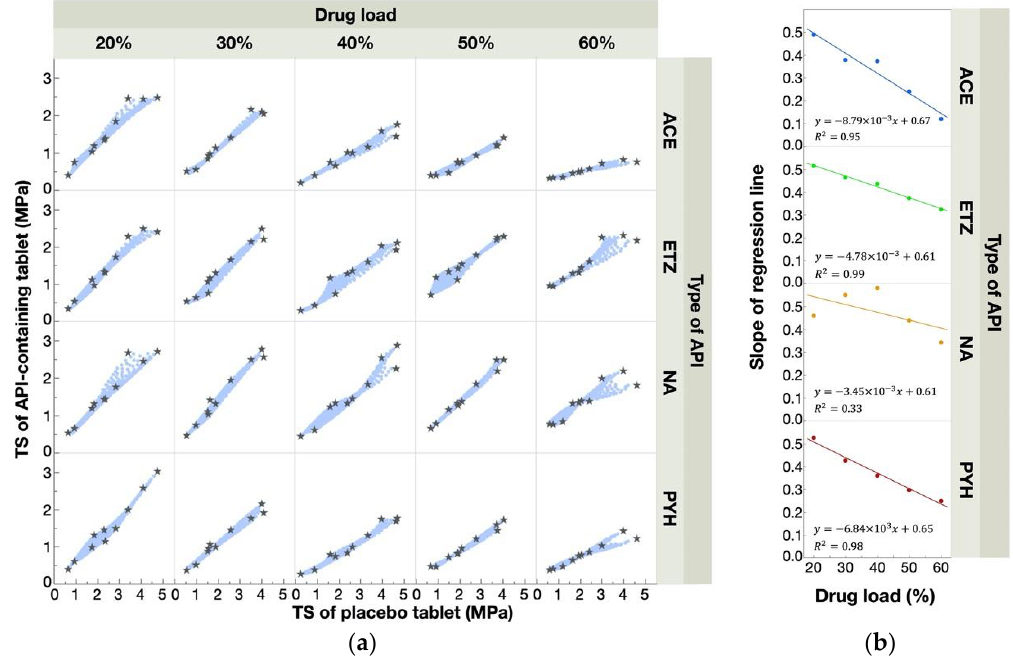
Figure 4. Relationships between the response surface for the TS of the placebo- and API-containing tablets. A scatterplot matrix ( a ) shows the relationships of TS values between placebo- and API-containing tablets. Gray stars represent experimental data points, and blue points represent the data predicted from response surfaces. The relationships between the slope of the regression lines and drug load ( b ).